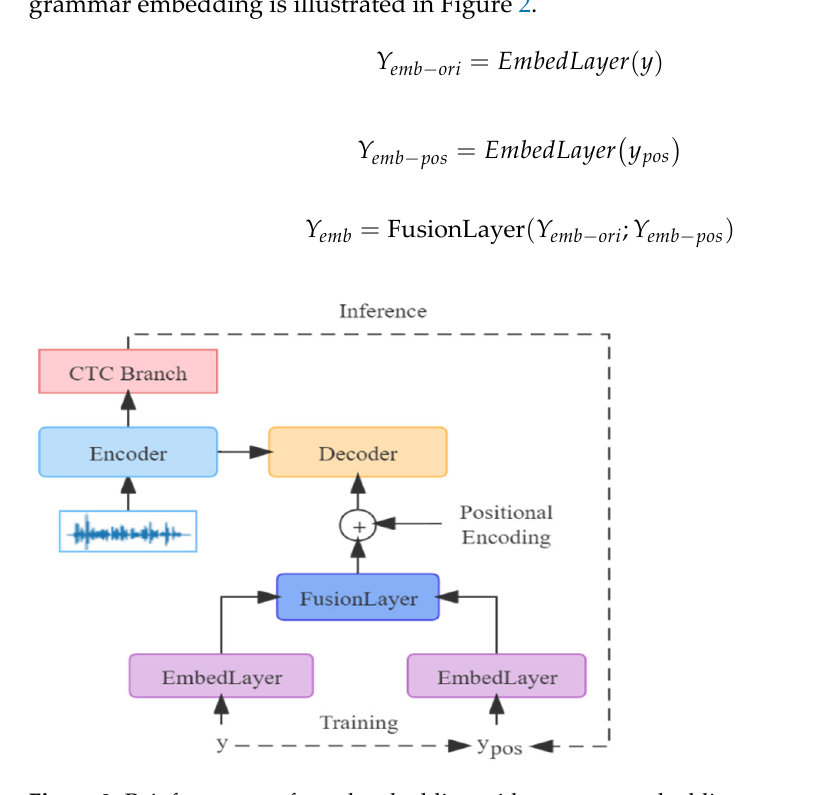
Figure 2. Reinforcement of word embedding with grammar embedding.